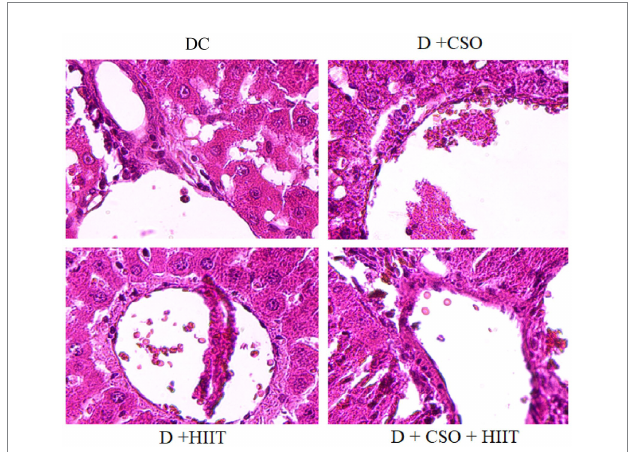
FIGURE 4 The effect of DC, D + CSO, D + HIIT, and D + CSO + HIIT on hepatic histopathology, 400 × magnification, DC, Diabetic control; D + CSO, Diabetic + camelina sativa oil; D + HIIT, Diabetic + HIIT; D + CSO + HIIT, Diabetic + camelina sativa oil +